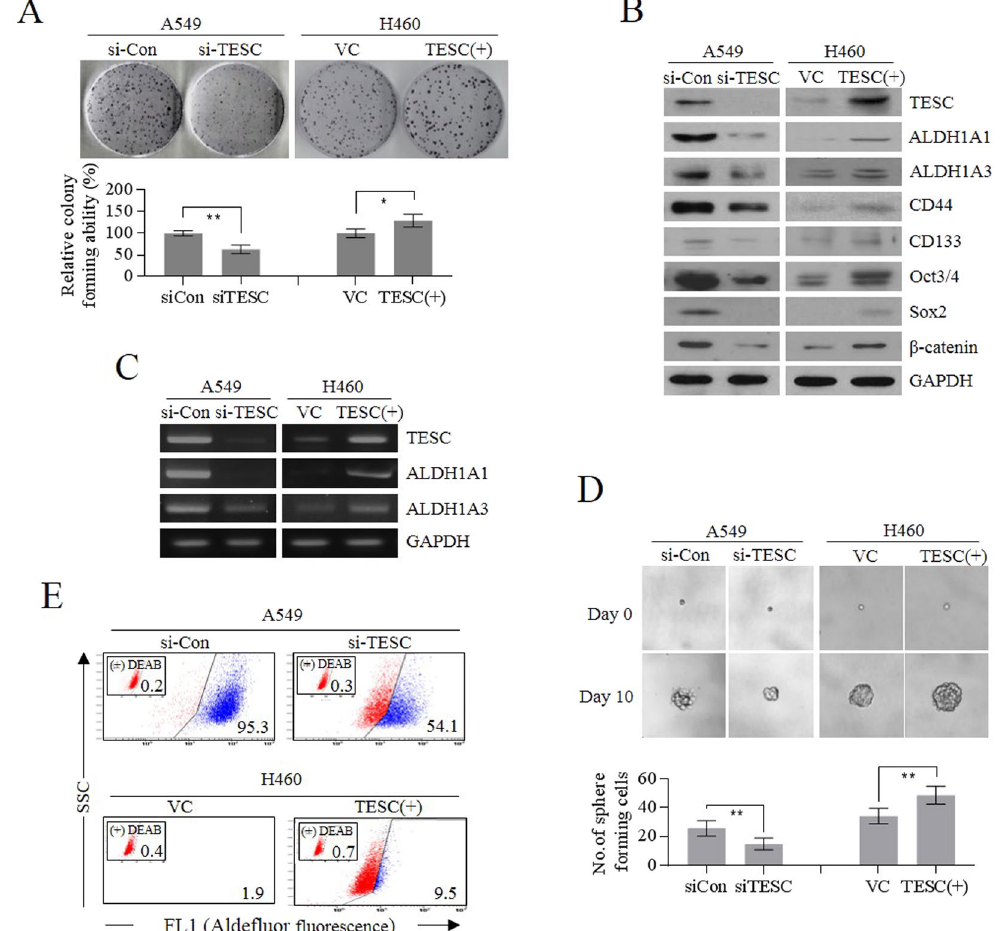
Figure 2. TESC regulates the CSC-like self-renewal properties in lung cancer cells. ( A ) Clonogenicities of TESC -knockdown A549 cells with siRNA and TESC -overexpressing H460 cells transfected with expression vector ( TESC -pcDNA3.1) were examined in vitro by colony formation assay. ( B ) Cellular levels of TESC and CSC markers including CD44, CD133, Oct3/4, Sox2, and β -catenin in TESC -knockdown A549 cells and TESC - overexpressing H460 cells. ( C ) RT-PCR analysis of ALDH1 isozymes in TESC -knockdown A549 cells and TESC -overexpressing H460 cells. ( D ) Changes in sphere-forming capacity in TESC -knockdown A549 cells or TESC -overexpressing H460 cells. ( E ) Changes in cellular ALDH1 levels were examined using ALDEFLUOR assay in TESC -knockdown A549 cells and TESC -overexpressing H460 cells. Data represent mean ± SD of three independent experiments using two-tailed t-test. * P < 0.05, ** P <